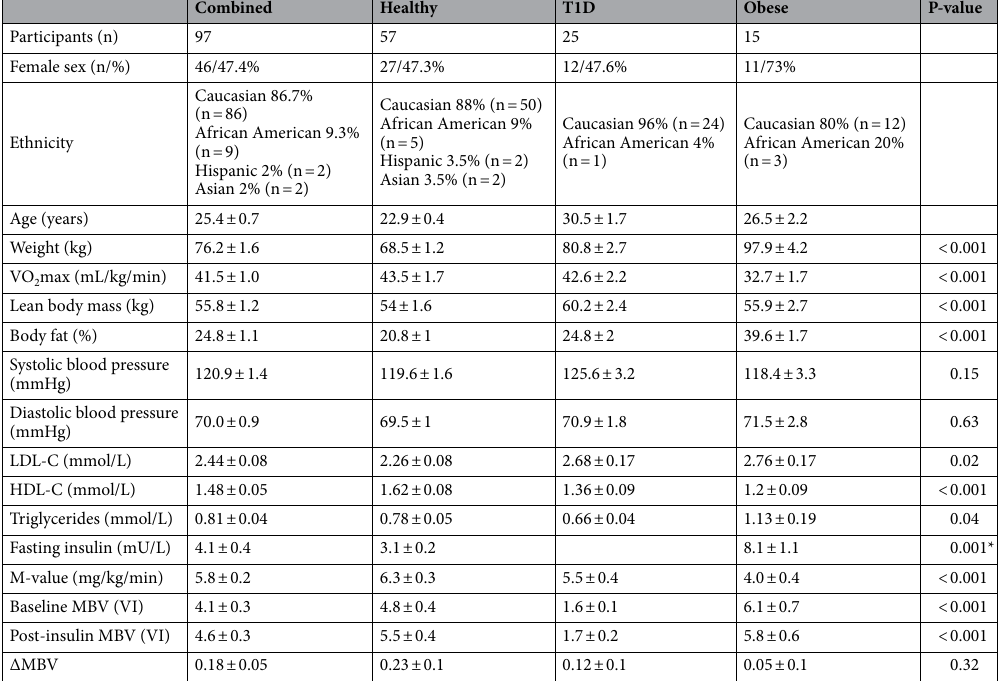
Table 1. Participants’ characteristics (mean ± SEM). T1D, type 1 diabetes; SEM, standard error of mean; LDL-C, low density lipoprotein cholesterol; HDL-C, high density lipoprotein cholesterol; VO 2 max, maximum oxygen consumption; ΔMBV, changes in microvascular blood volume following insulin clamp; VI, video intensity; P-values were determined by Brown-Forsythe and Welch ANOVA tests comparing the three groups. (healthy, T1D, obese). *Indicates unpaired t-test with Welch’s correction comparing participants who are healthy and